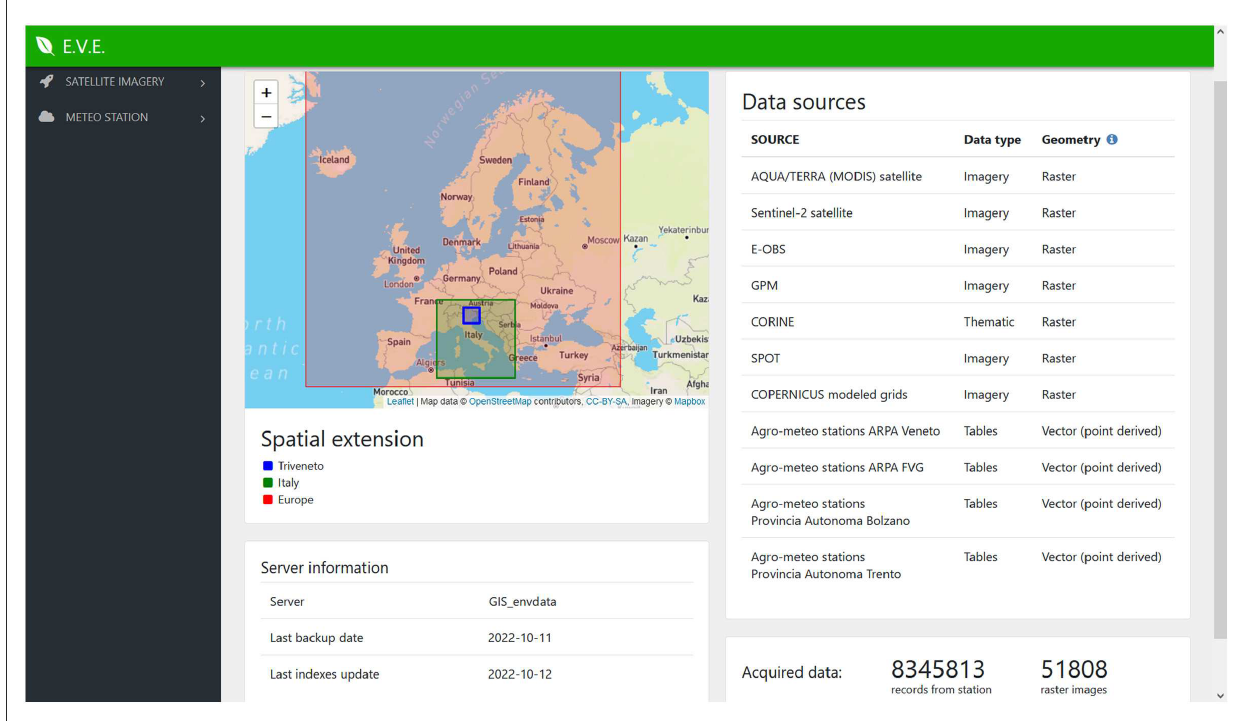
FIGURE7 Web application used as catalog of EVE data. It presents both satellite images and ground sensed dataset.